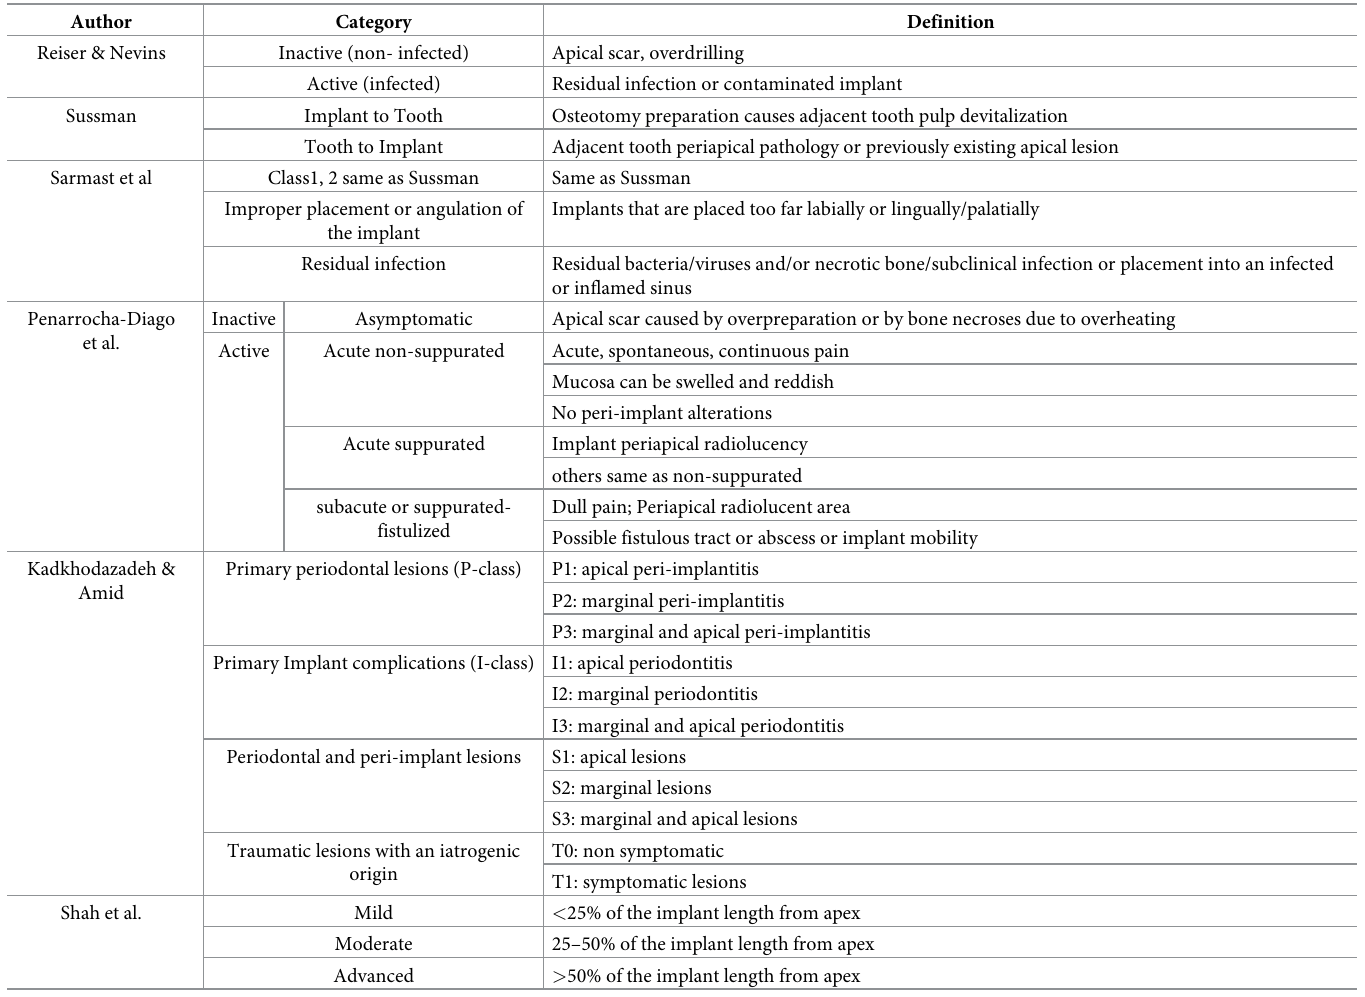
Table 1. The present classification systems regarding the